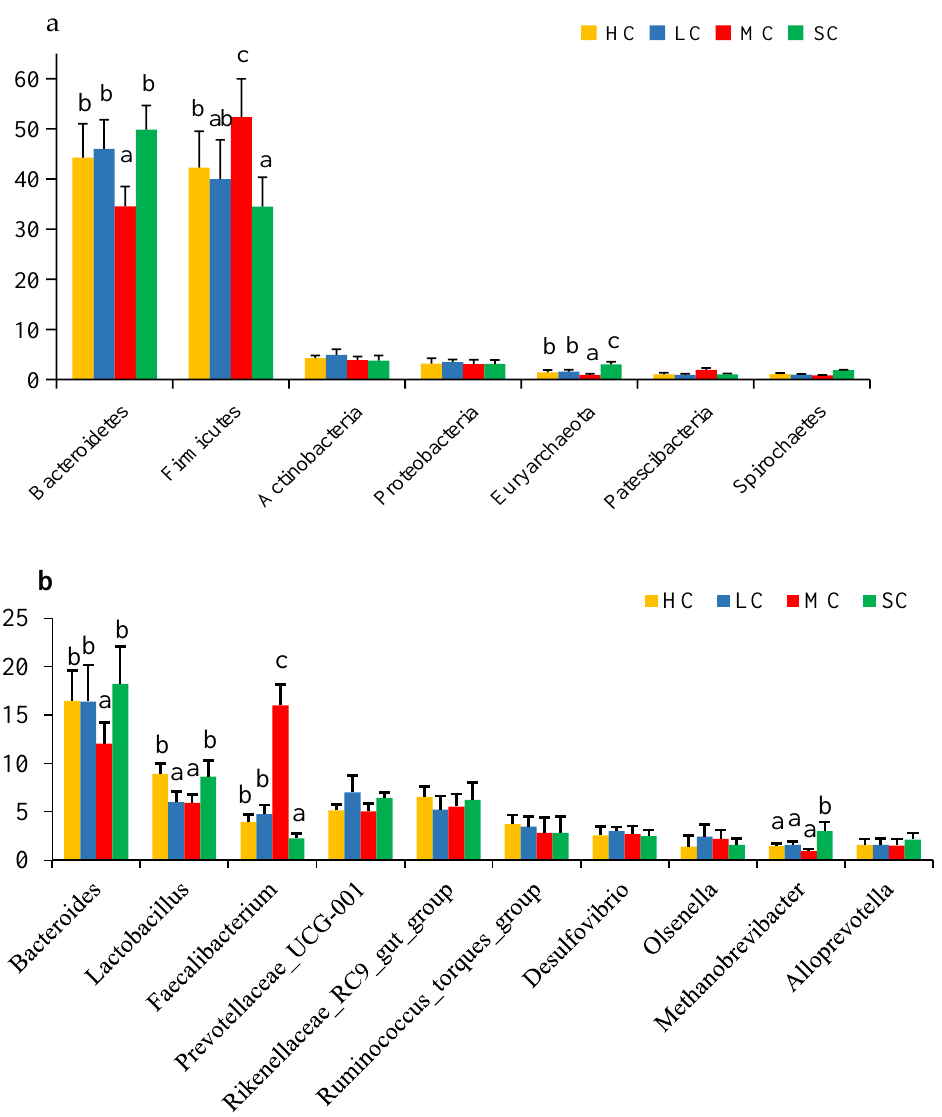
Figure 7. Relative abundance (% reads) of ( a ) the most dominant phylum and ( b ) the most dominant genus in the caecal microbiome of birds from in HC, LC, MC, and SC. Error bars represent the SE of samples. Boxes with different letters above the error bars are significantly different at p < 0.05. HC,